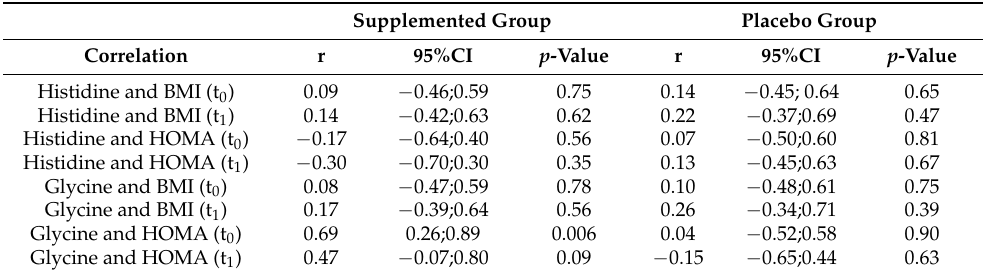
Table 7. Correlations between the two amino acids, histidine and glycine, and between HOMA and BMI in the two groups at both time